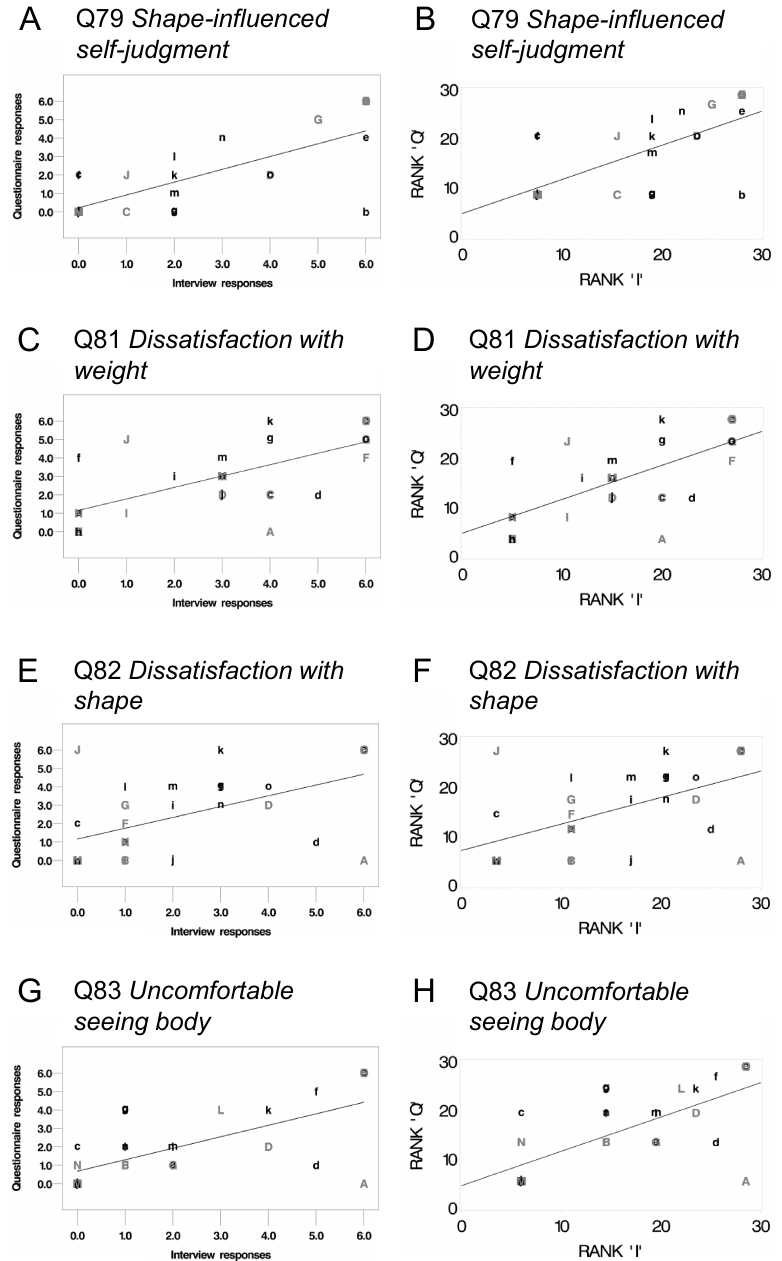
Figure 2. Panel of Pearson linear regression and Spearman rank order correlations plots. ( A , C , E , G ) are Pearson linear regression plots with scaled score response (0–6) from questionnaire (ordinate) regressed from interview (abscissa). Note: Since the distributions of response for these items are not normal, Pearson linear regression is not appropriate, and the presentation of these plots are for visual aid. ( B ) (R 2 = 0.72, p < 0.001), ( D ) (R2 = 0.69, p < 0.001), ( F ) (R2 = 0.54, p < 0.002), and ( H ) (R2 = 0.70, p < 0.001) are Spearman rank order correlation plots with the rank of questionnaire response (ordinate) and the rank of interview response (abscissa). Item number for ( A – H ) noted below the title of each plot. All items significant after Bonferroni correction (k = 4, α = 0.0125). See Appendix A for the full text of each item.